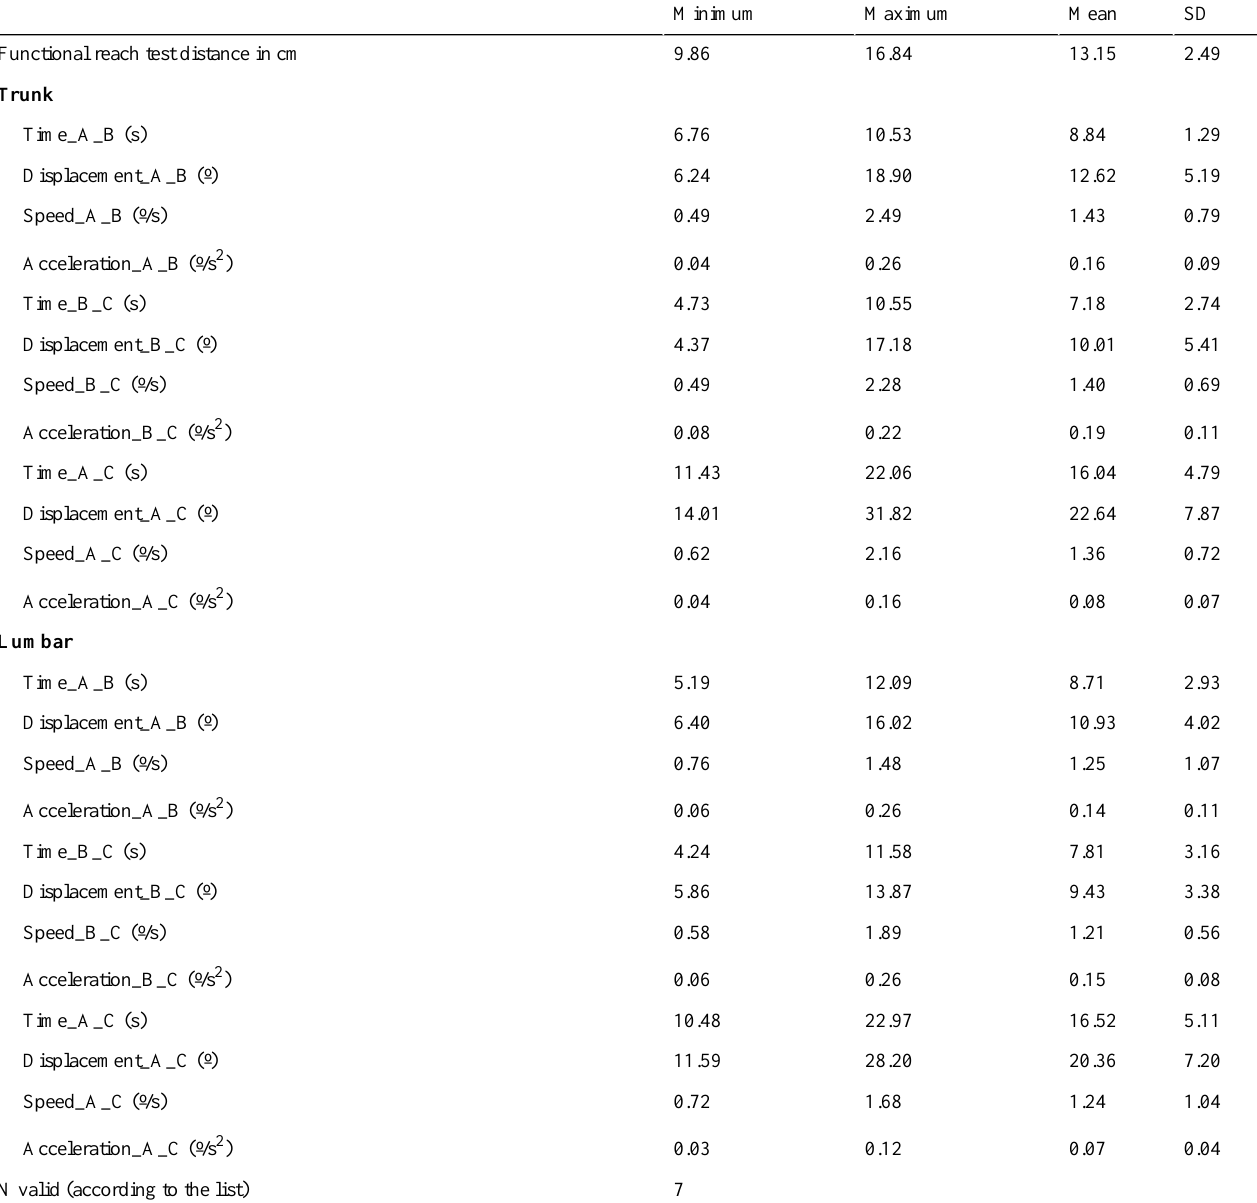
Table 2. Description of the kinematic variables of FRT depending on the placement of the mobile device.